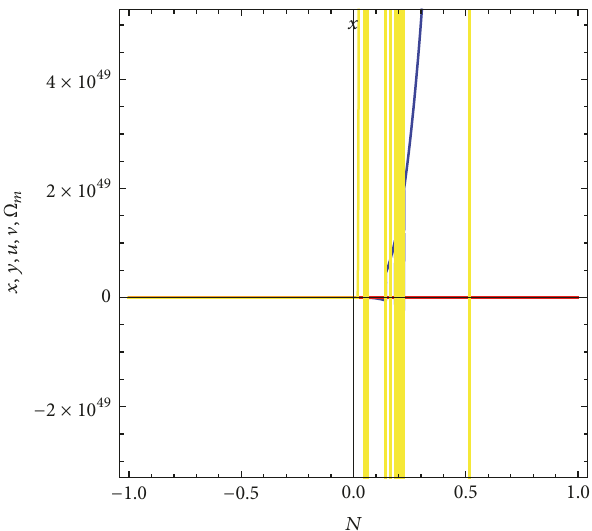
Figure 11: Plot of ( 11 ) variations of 𝑥 (blue), 𝑦 (green), 𝑢 (orange), V (red), and Ω 𝑁 near 𝑃 𝛾 = 1 , 𝛿 = 1 , and 푚 (yellow) versus 12 , for 𝜆 = −0.5 . The position corresponding to 𝑁 = 0 is the fixed point under consideration.